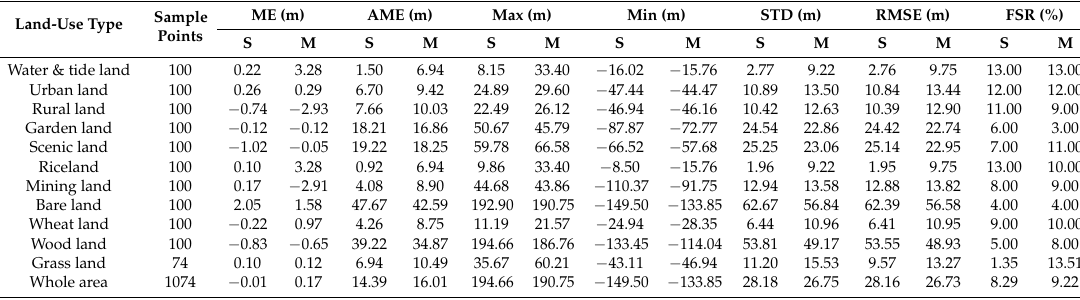
Table 8. Statistical measures of the difference between the calibrated GDEM2 and GNSS measurements by using the first sample set for validation (S signifies simple linear regression and M multiple linear